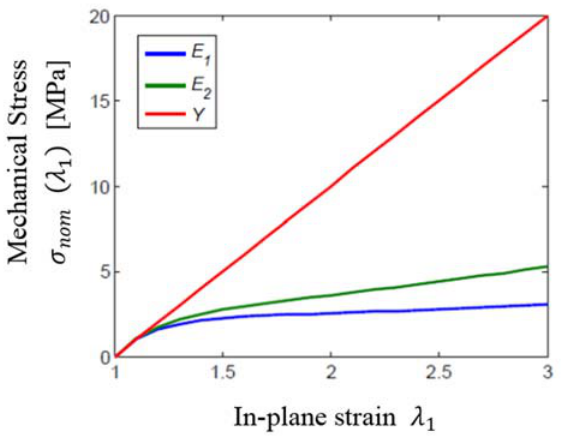
Figure 10. Comparison between the Young’s Modulus of the elastomer ( Y “ 0.1 GPa) and the evaluated elastic modulii E 1 , E 2 from Equation (15) (taking λ 2 “ 1 q for both in-plane directions. The actual elastic moduli in both directions decrease as the elastomer undergoes large deformation. The elastomer becomes anisotropic under bi-axial loading.